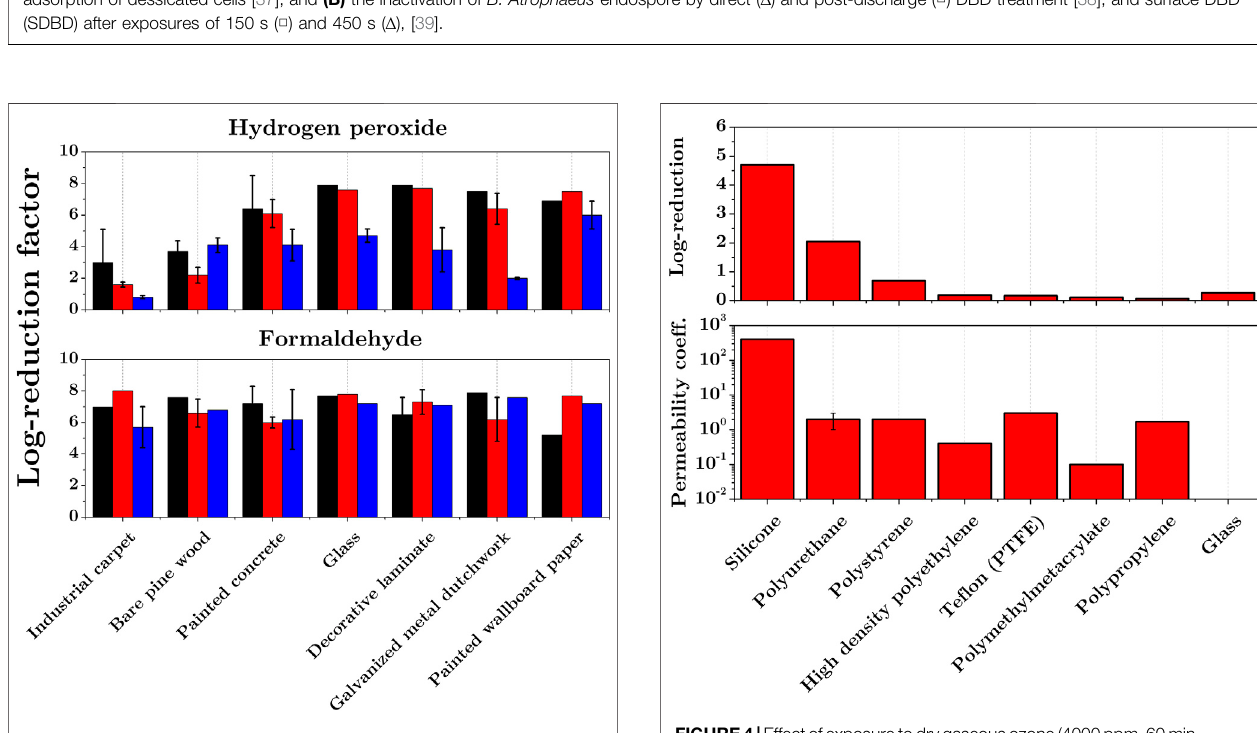
FIGURE 3 | Inactivation of B. Anthracis (black), B. Subtilis (red) and G. Stearothermophilus (blue) endospores dried on various surface materials and exposed to hydrogen peroxide H 2 O 2 (top graph) and gaseous formaldehyde CH 2 O (bottom) , adapted from [41, 42].